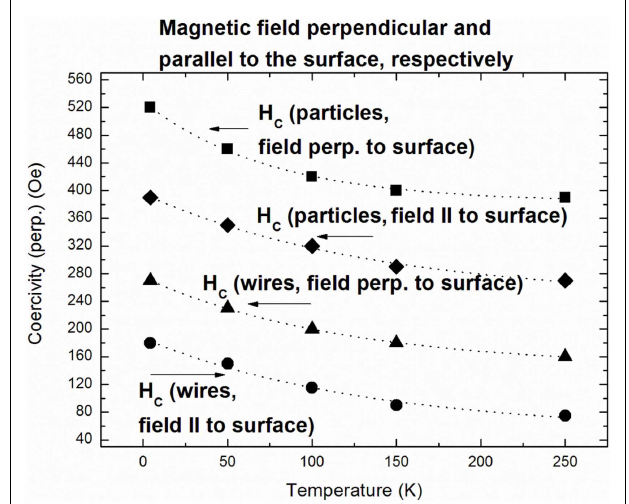
FIGURE 3 |Temperature dependency of coercivities measured in easy axis (magnetic field parallel to the pores) and hard axis (magnetic field parallel to the pores) magnetization, respectively (Rumpf et al., 2012b) .